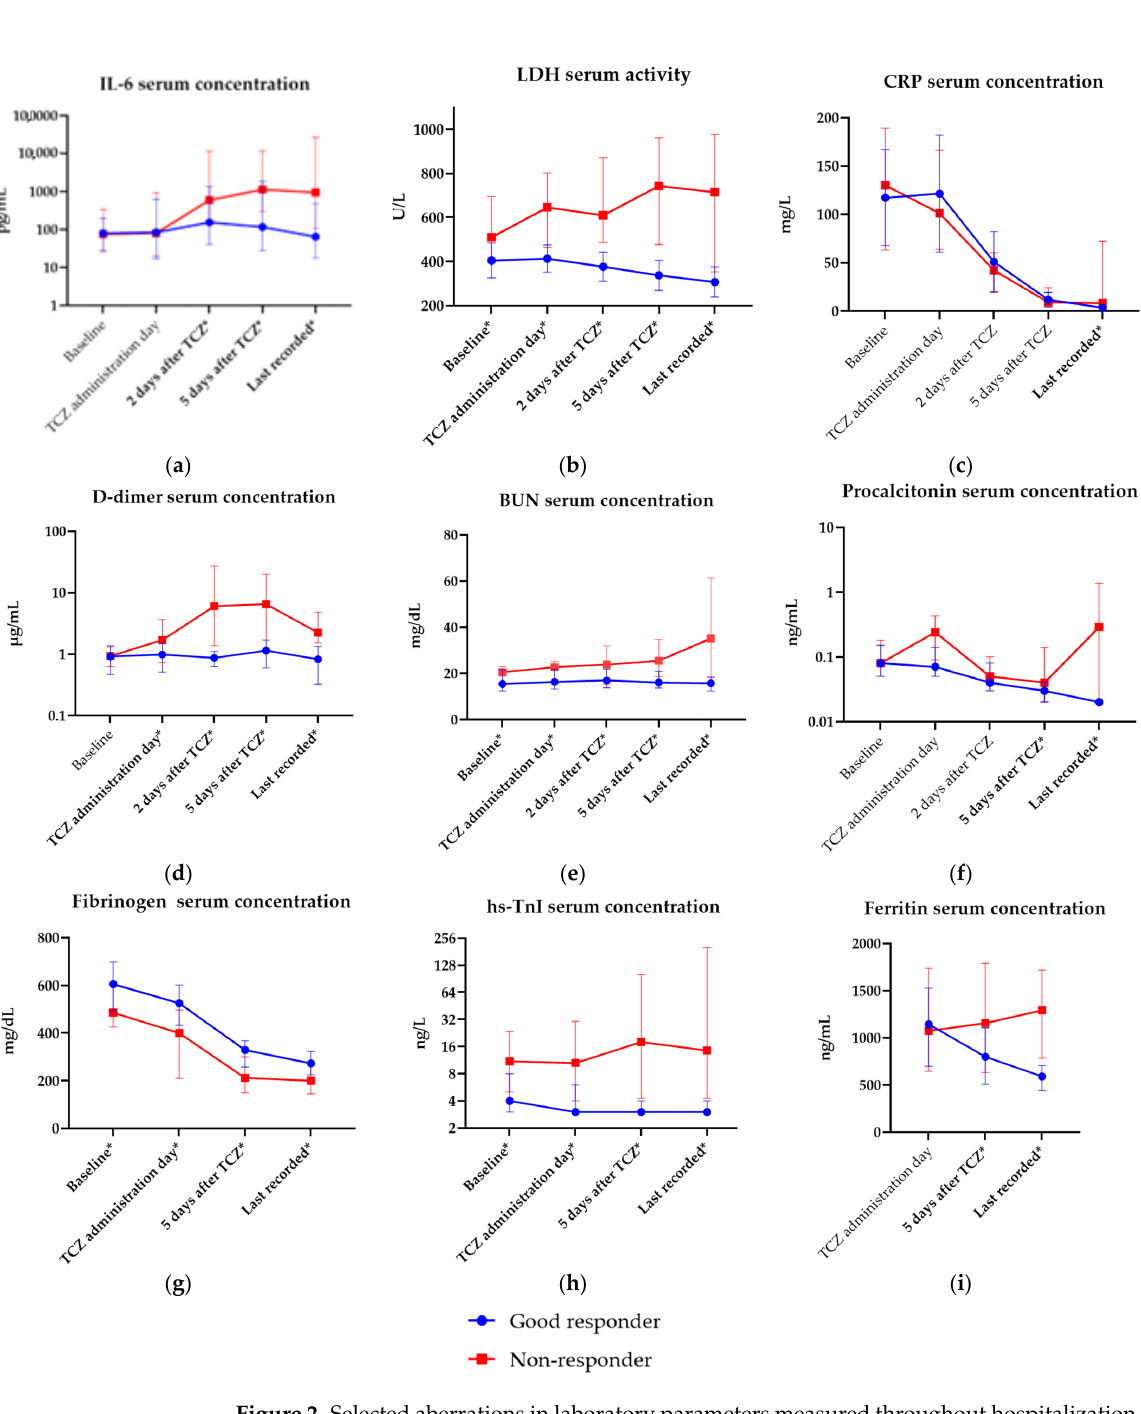
Figure 2. Selected aberrations in laboratory parameters measured throughout hospitalization. Statistically significant differences are bolded and marked with *. ( a ) Interleukin-6 (IL-6) serum concentration (pg/mL); ( b ) lactate dehydrogenase (LDH) serum activity (IU/L); ( c ) C-reactive protein (CRP) serum concentration (mg/L); ( d ) D-dimer serum concentration (µg/mL); ( e ) blood urea nitrogen (BUN) serum concentration (mg/dL); ( f ) procalcitonin serum concentration (ng/mL); ( g ) fibrinogen serum concentration; ( h ) high sensitive troponin I serum concentration (ng/L); ( i ) ferritin serum concentration (ng/mL). Points represent median values of variables and whiskers re fl ect in- terquartile ranges (IQR).